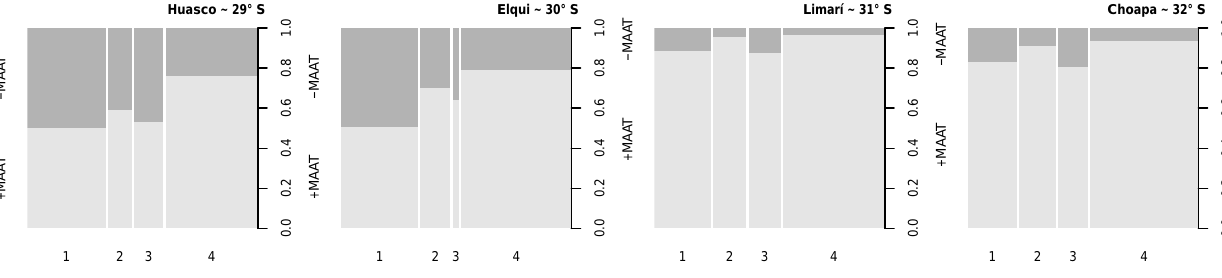
Figure 3. Proportion of active (1), inactive (2), intact (3), and relict (4) rock glaciers located below ( + MAAT) and above ( − MAAT) the 0 ◦ C MAAT isotherm altitude (ZIA) within each watershed. Table 2. Model coefficients and goodness-of-fit statistics for the linear mixed-effects model for annual air